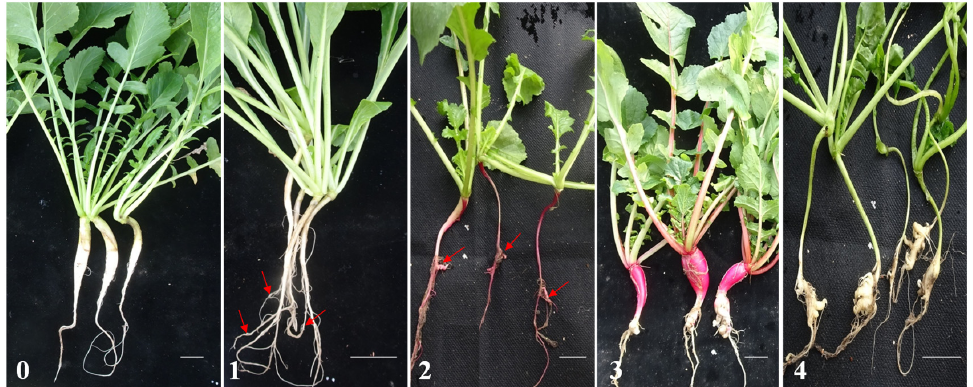
Figure 1. Grades of clubroot symptoms in radish seedlings at 60 days after inoculation with P. brassicae . Disease symptoms were assessed according to a five-point scale ranging from 0 (no symptoms) to 4 (severe clubroots). Scale bar = 2 cm. Arrows indicate a few small clubs on lateral roots.